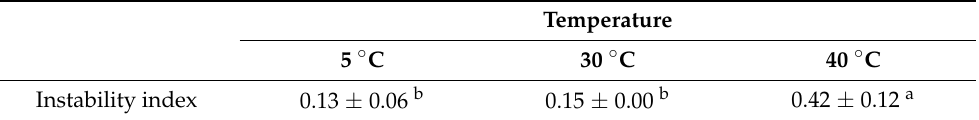
Table 1. Instability index of HA-based nanoemulsion containing P. pubescens oil at temperatures of 5, 30, and 40 ◦